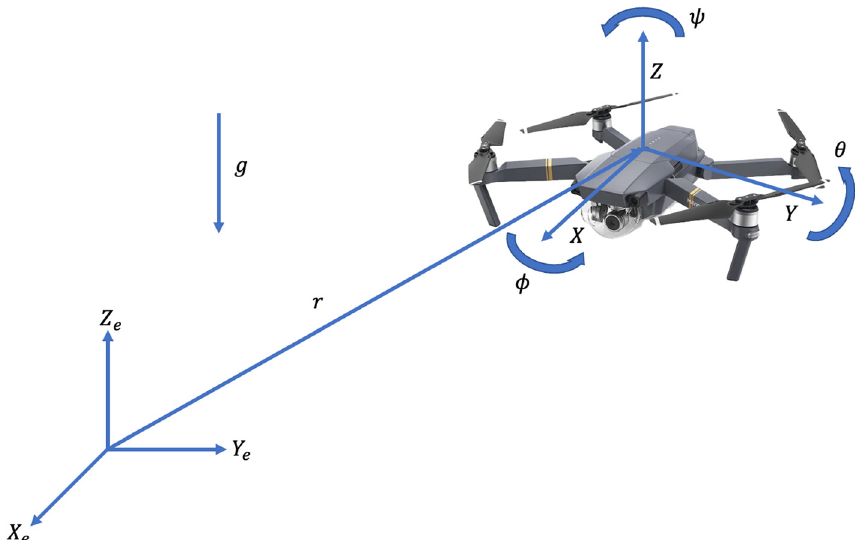
Figure 2: Quadcopter reference frames.